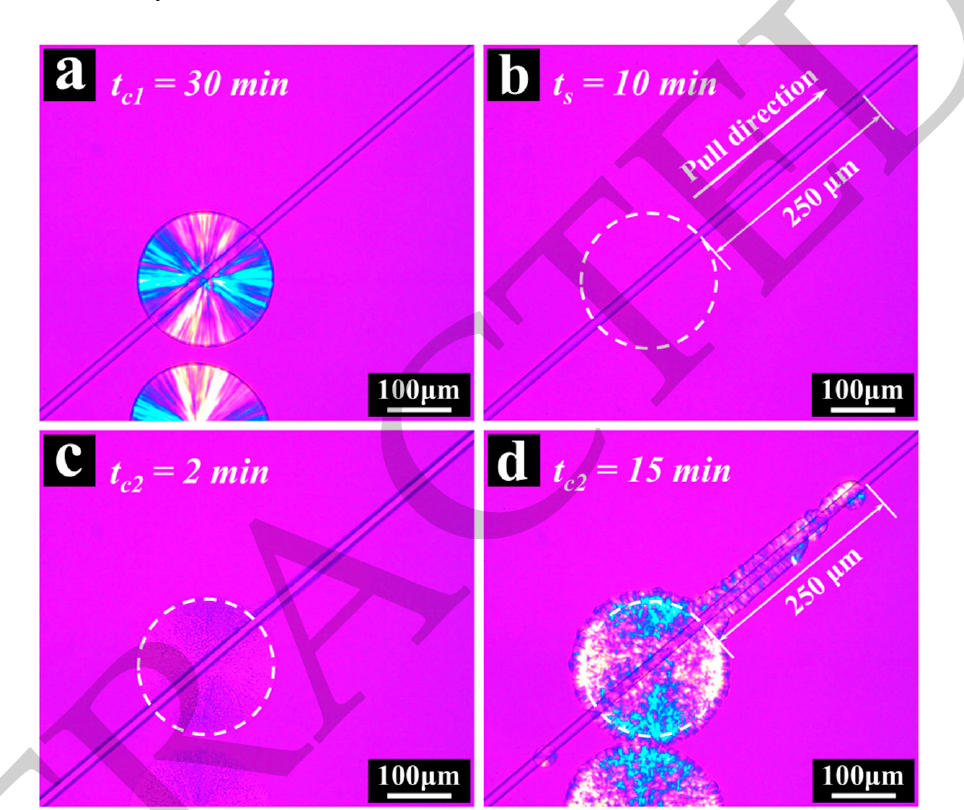
Figure 2. The selected optical micrographs obtained at different fiber-pulling experimental stages. ( a ) t c1 = 30 min, T c = 135 °C; ( b ) t s = 10 min, T s = 170 °C; ( c ) t c2 = 2 min, T c = 135 °C; ( d ) t c2 = 15 min, T c = 135 °C. The pulling rate and distance were 62.5 μ m /s and 250 μ m, respectively.